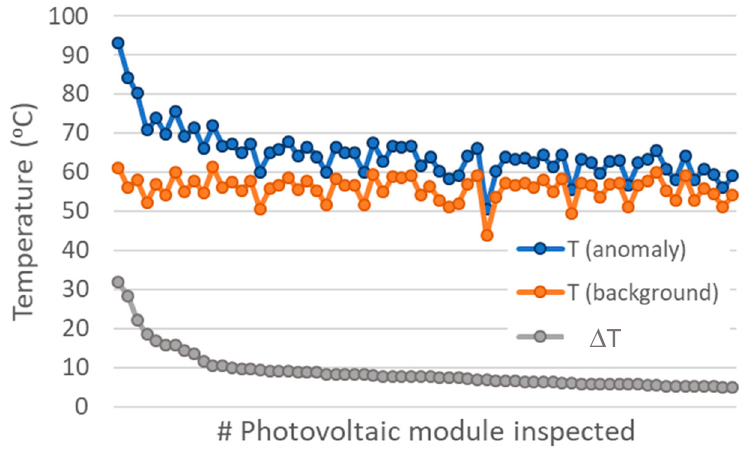
Figure 11. Temperatures measured with the thermocamera in selected areas of the modules: Area considered an anomaly (Ar1) is indicated by blue points, area considered background (Ar2) by orange points and the difference between them by grey points.